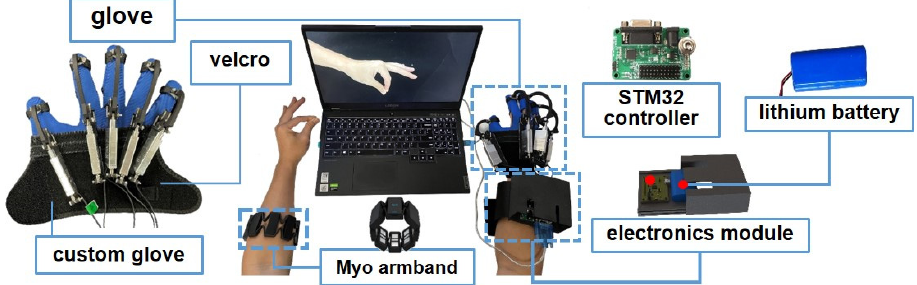
Figure 19. EMG-Controlled Robotic Hand Rehabilitation System.